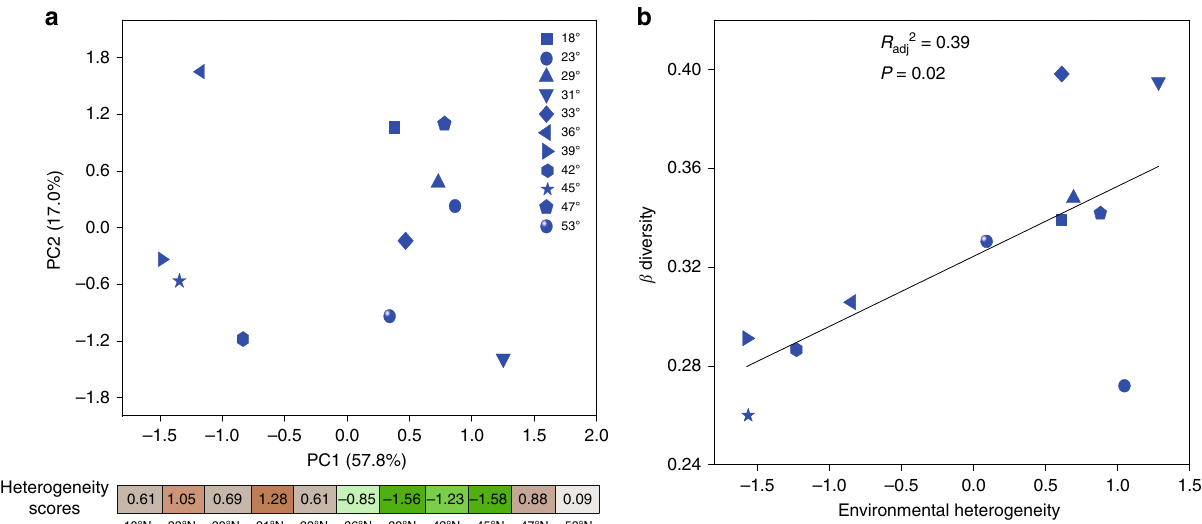
Fig. 7 The relation between β diversity and overall environmental heterogeneity. a Principal component analysis based on the coef fi cients of variation (CVs) of six environmental parameters (Supplementary Table 7). The heterogeneity score re fl ects the overall environmental variability in a region; a high score (orange color) represents a high heterogeneity; a low score (green color) represents a low heterogeneity. The heterogeneity score is